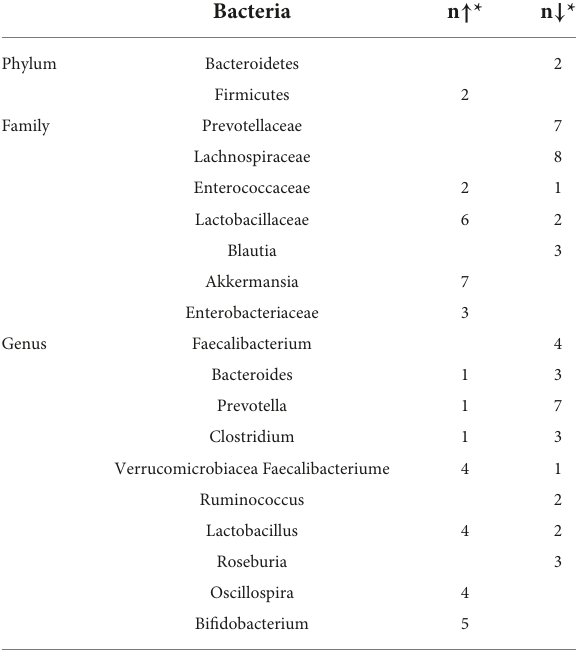
TABLE 1 Altered abundance of gut microbiota in PD patients compared to